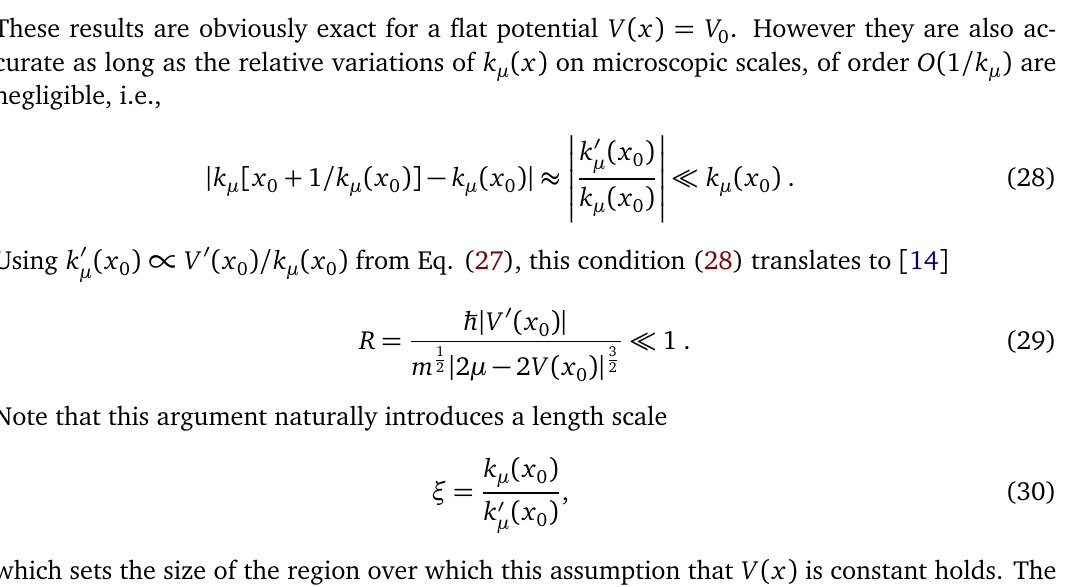
Figure 2: Contour integrals used in the integral representations of the kernel. Crosses, × , indicate the poles of the Green’s function which are just above the real = ( µ , ∞ ) is the contour used in representation Eq. (23) and Γ axis. Γ 1 that is used for representation Eq. (24). The contour Γ Γ ∪ Γ and is taken to be a semi-circle in the lower half of the complex plane whose 1 2 radius is taken to ∞